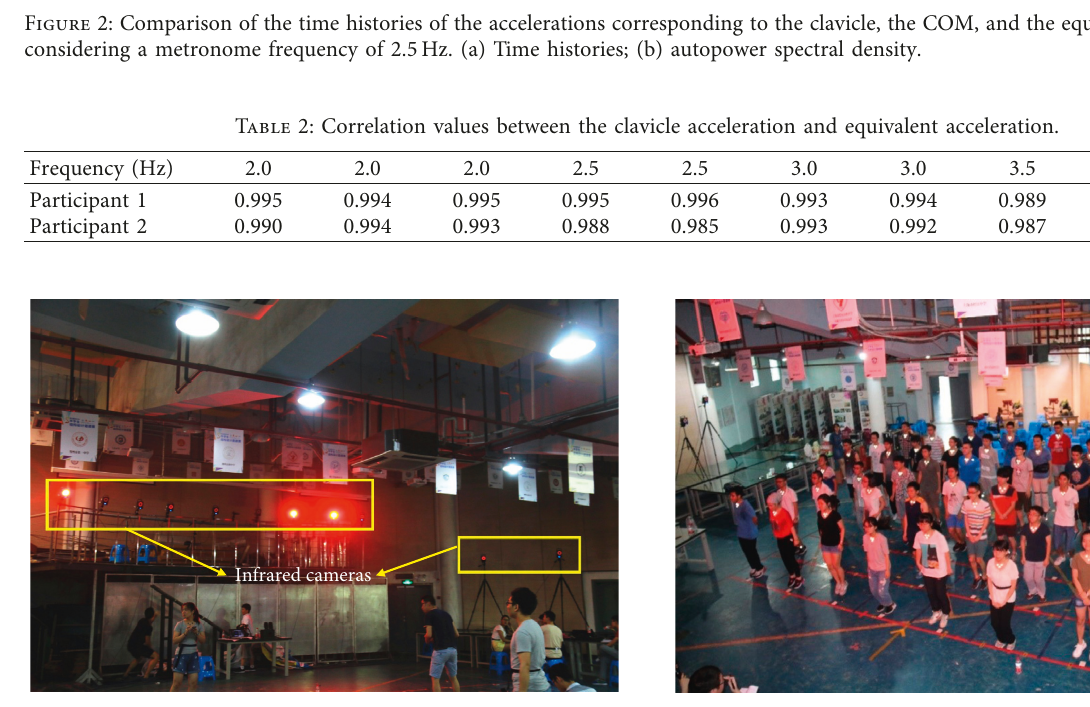
Figure 4: Forty-eight participants standing in the reference